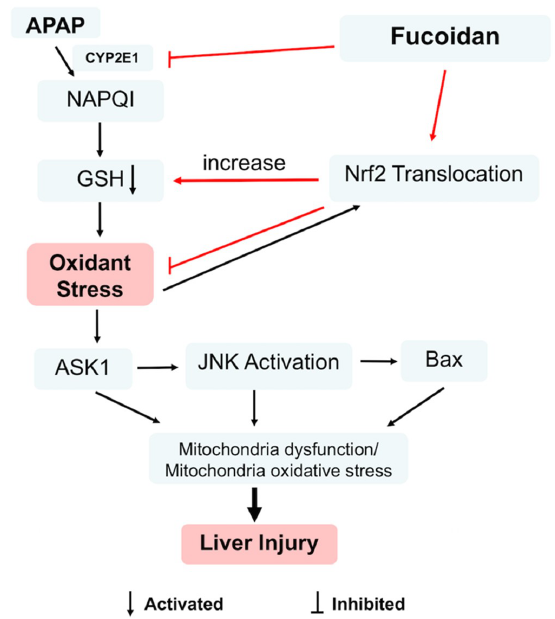
Figure 9. Nrf2 was involved in the protective effect of fucoidan against